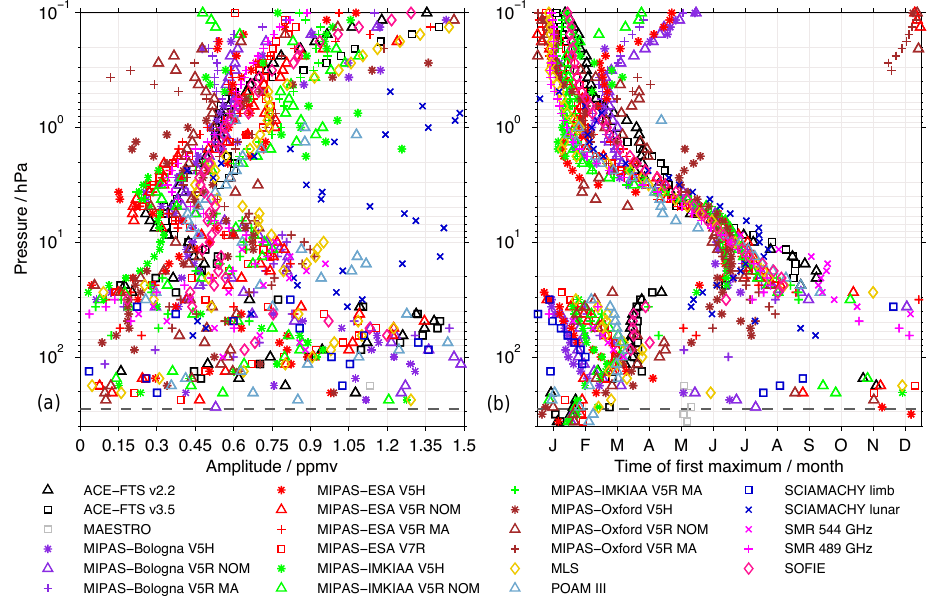
Figure 3. As Fig. 2 but here for the latitude band from 85 to 75 ◦ S. Note that the scale of the amplitude axis is extended compared to the previous figure to accommodate the larger spread among different data sets.